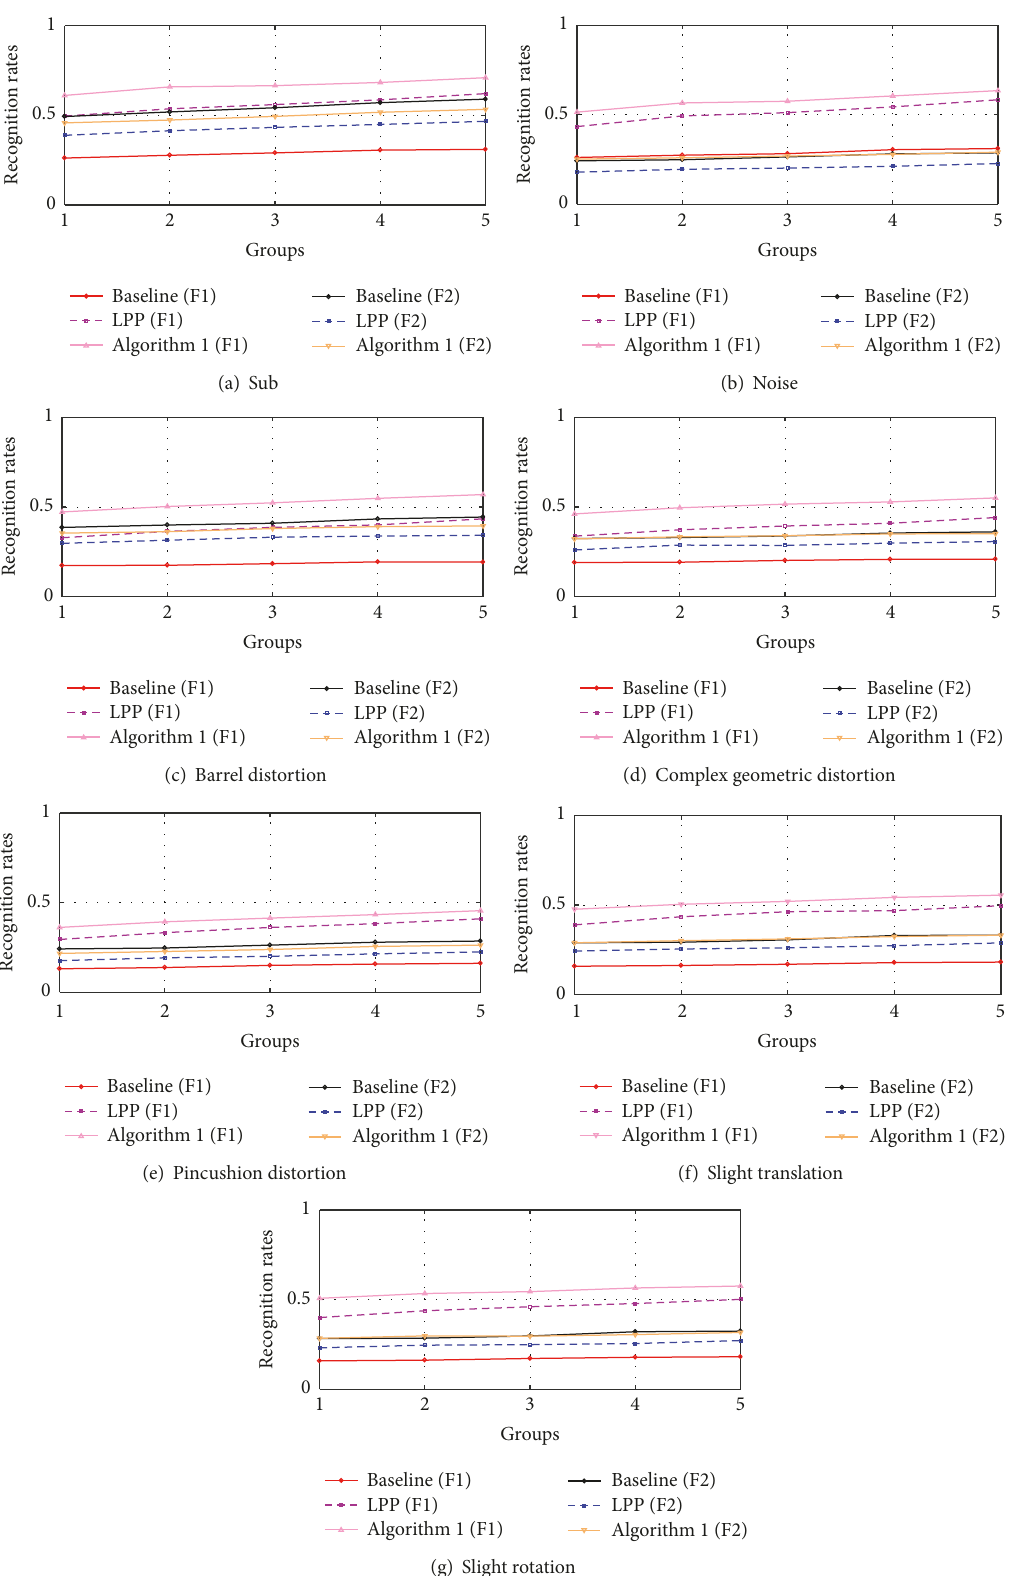
Figure 13: The recognition rates on sub, noise, geometric distortion, slight translation, and slight rotation Extended Yale B face databases over “F1” and “F2”